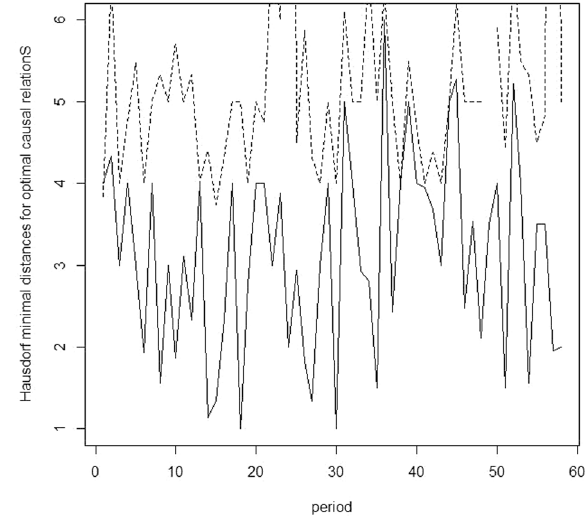
Fig. 2 Optimal causal correlation coef fi cient from MSP (or Y) to MHP (or X) or MaxCCC X t j Y t . MSP stands for Monetary Soft Power, while MHP stands for Military Hard Power. MaxCCC Y t j X t is the maximal causal correlation coef fi cient from Y to X, where t denotes t ’ th period.